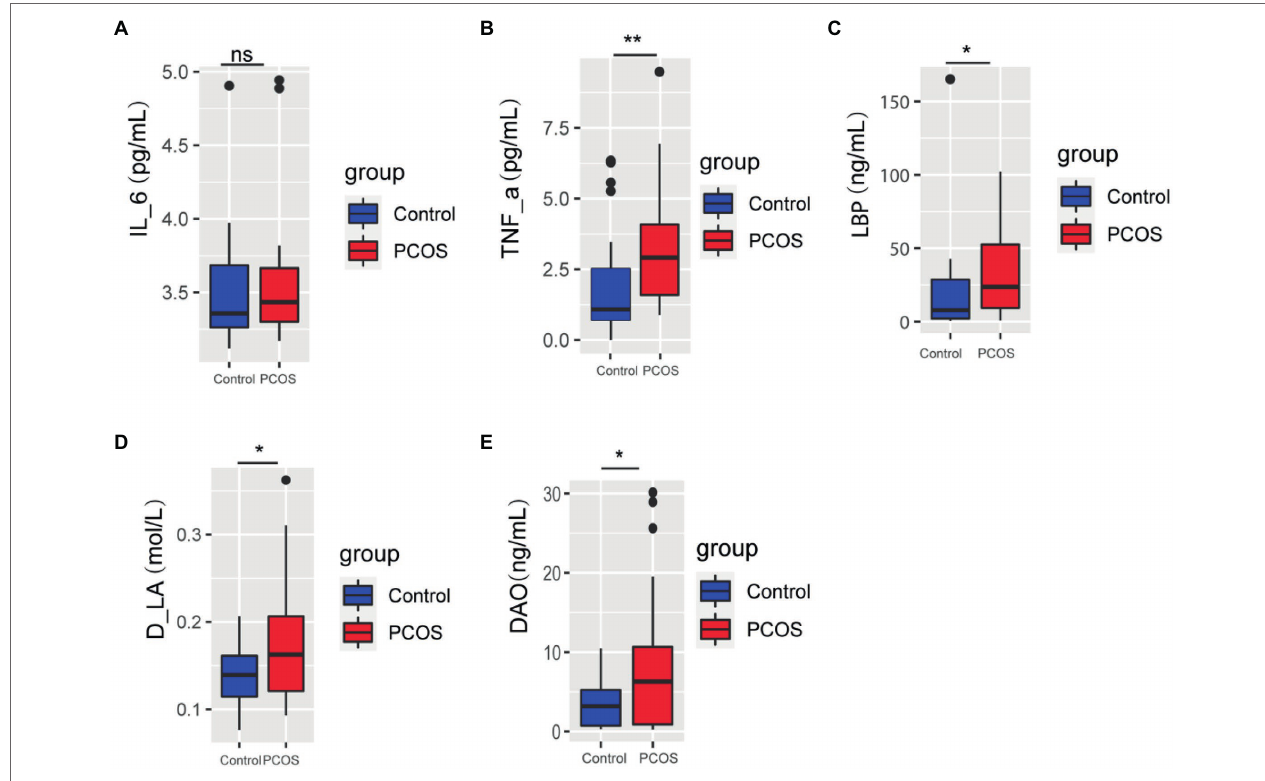
FIGURE 1 | (A-E) Inflammation and gut permeability analysis of PCOS and healthy controls. A p < 0.05 (two-tailed) was the significance test level. PCOS, Polycystic ovary syndrome, LBP, Lipopolysaccharide-binding protein, D-LA, D-lactic acid, DAO, Diamine oxidase. * p ≤ 0.05; ** p ≤ 0.01; and *** p ≤ 0.001.